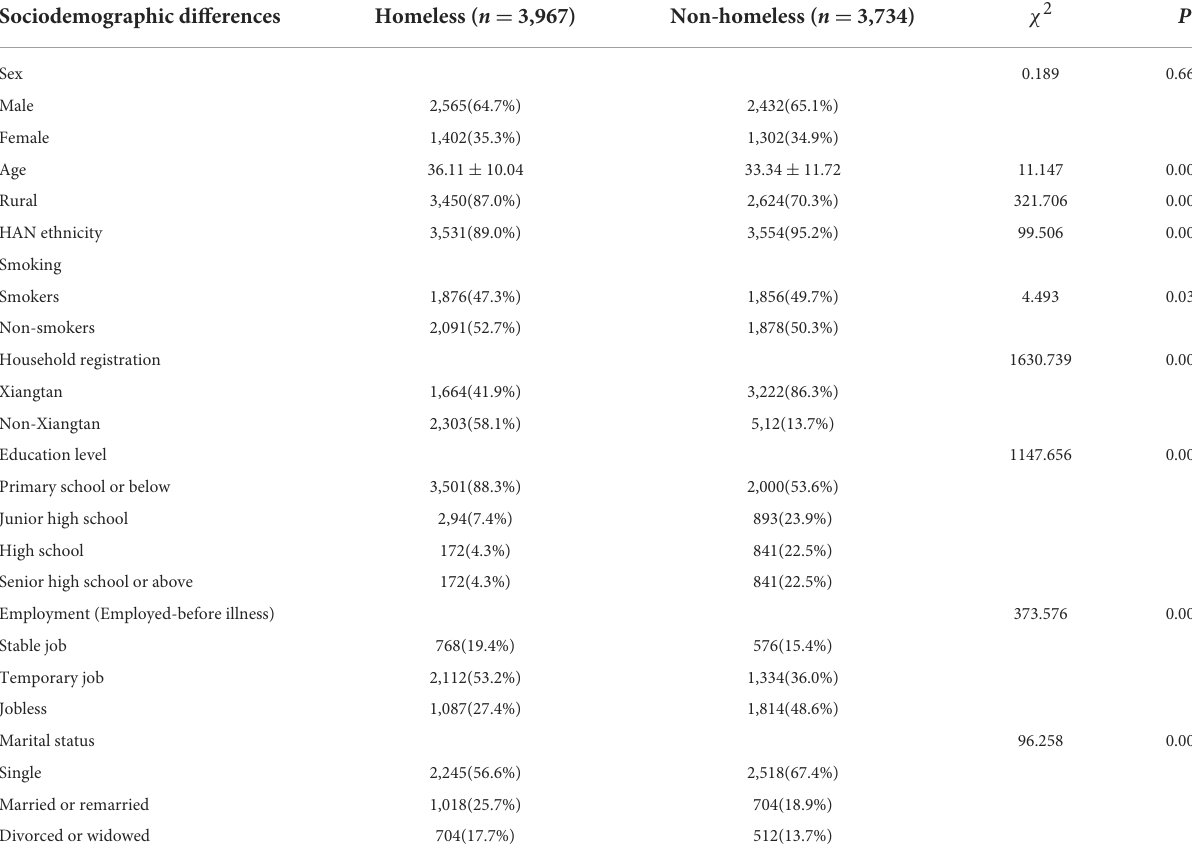
TABLE 1 Comparison of sociodemographic differences between the homeless and non-homeless schizophrenia patients. Sociodemographic